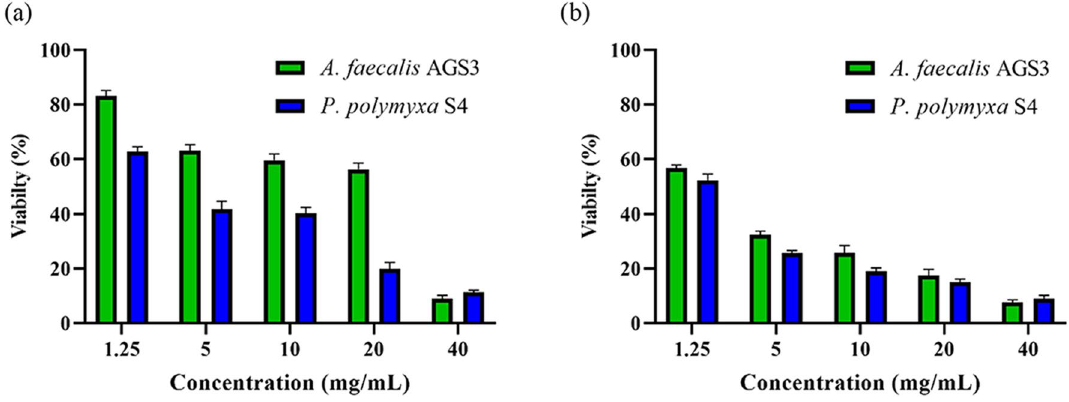
Figure 5. MTT assessment of MCF-7 cells after treatment for ( a ) 24 h and ( b ) 48